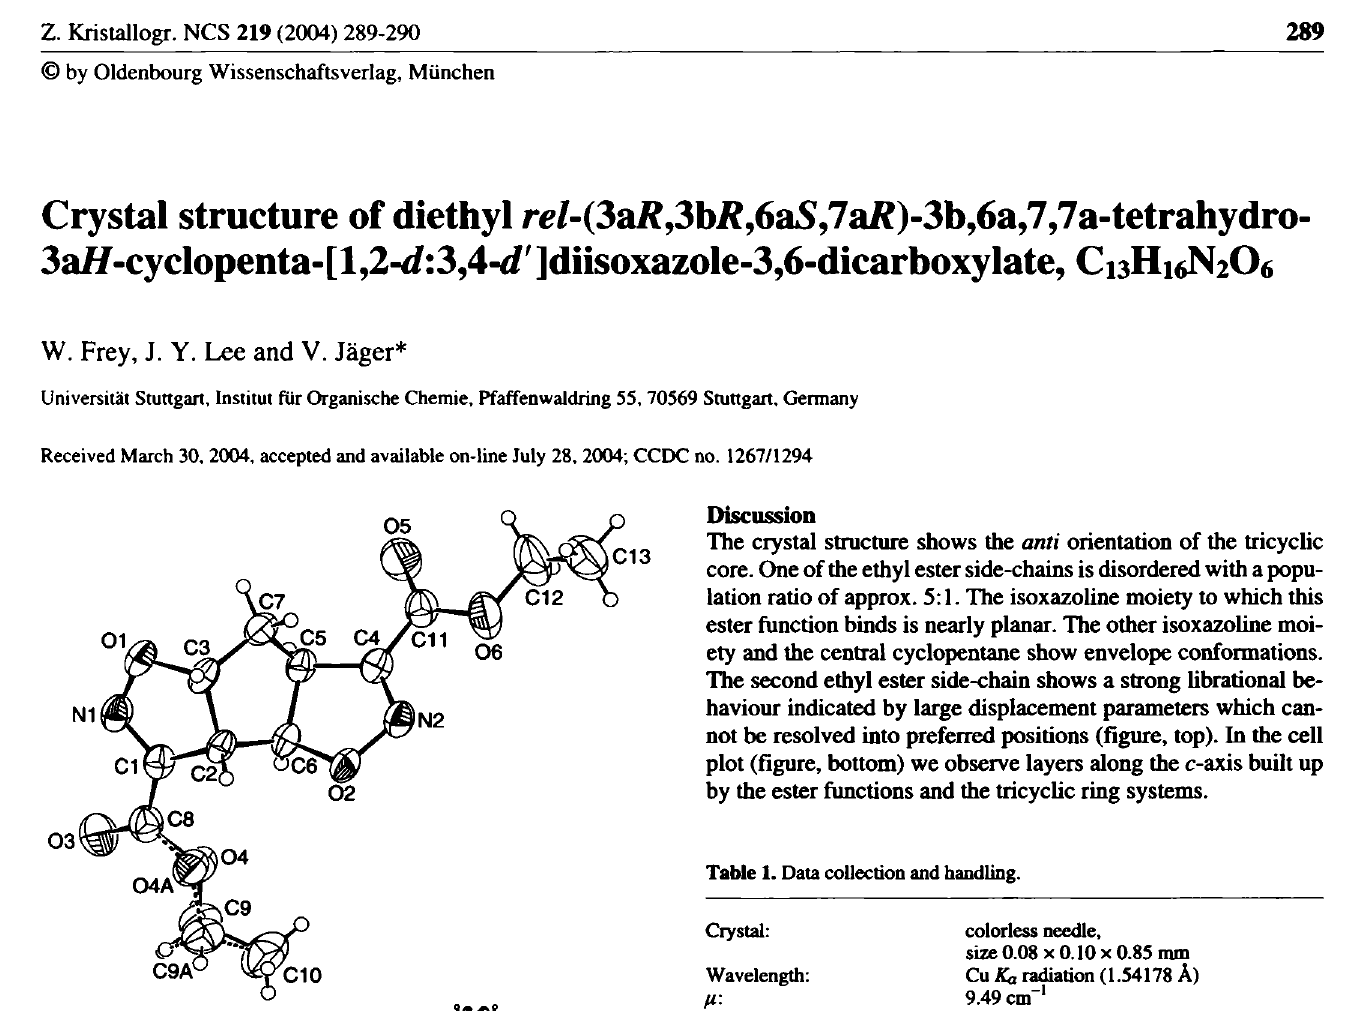
Table 1. Data collection and handling.